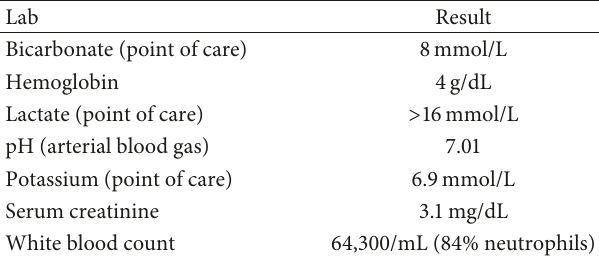
Table 1: Pertinent laboratory